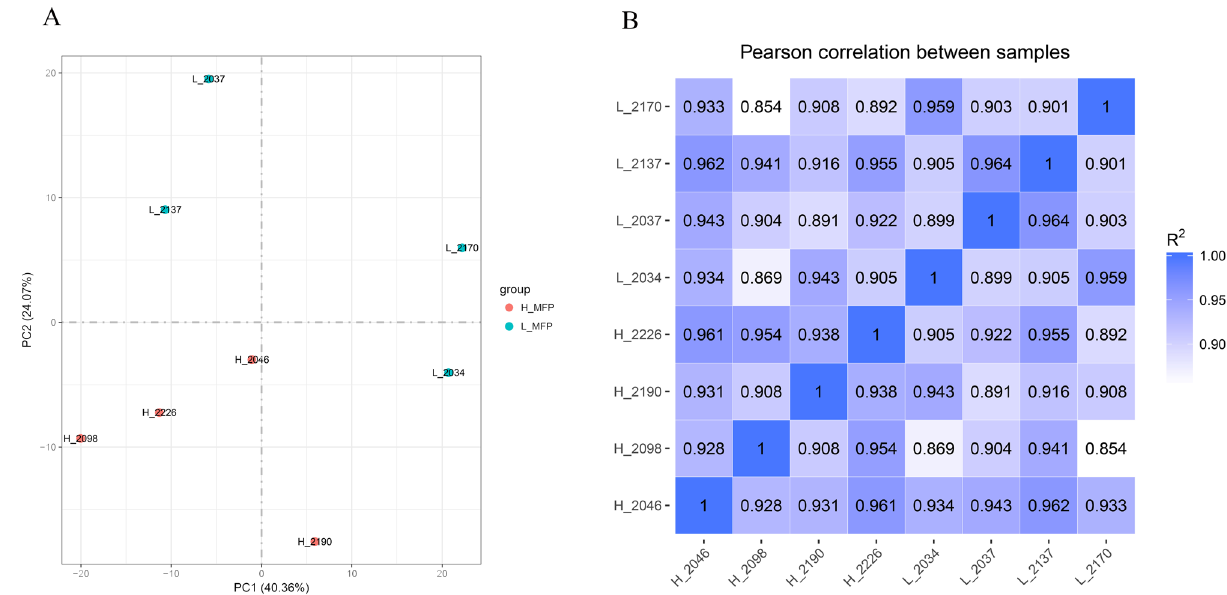
Figure 1. Principal components and correlation analysis. ( A ) Results of sample principal component analysis; ( B ) heat map of inter-sample correlation